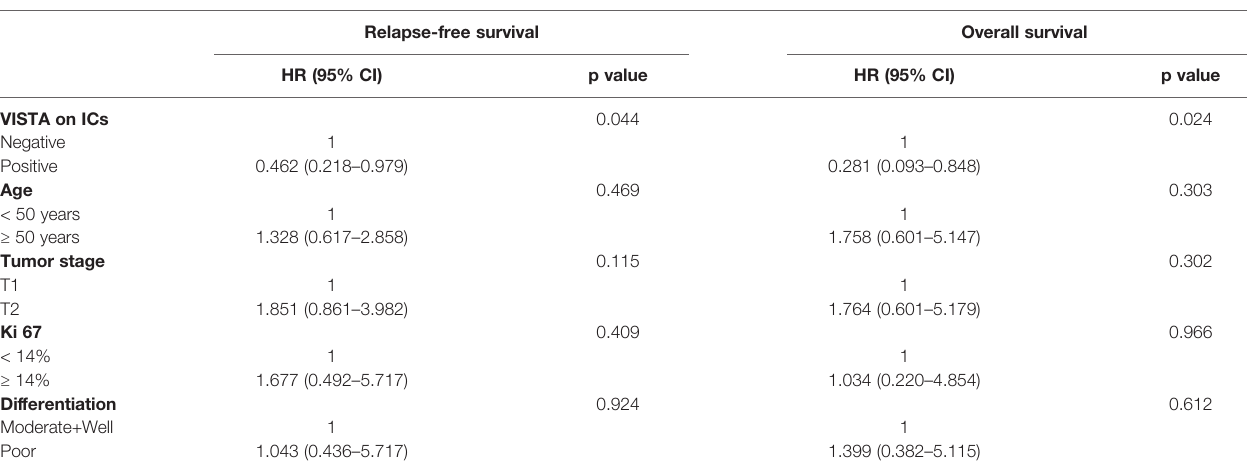
TABLE 4 | Multivariate analysis for patients with T1-2N0 TNBC.